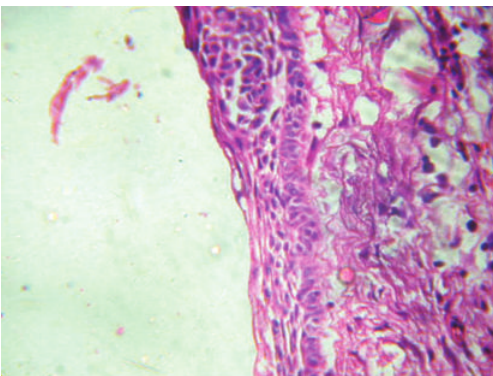
Figure 6: A cystic lumen lined by proliferative odontogenic epithe- lium (H and E Stained × 100).